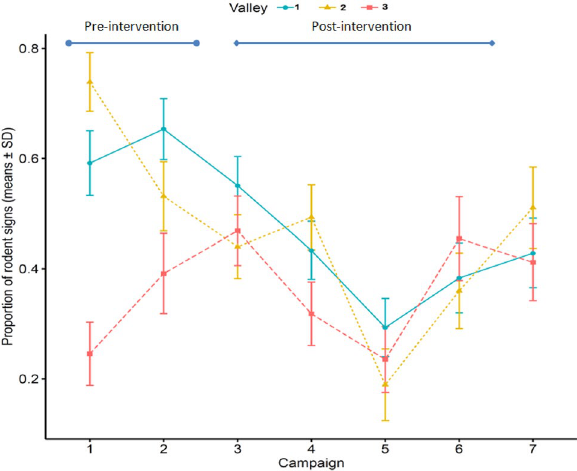
Figure 3. Mean with standard deviation of rodent infestation by campaign and valley (valley 1—blue, valley 2—yellow & valley 3—red colour